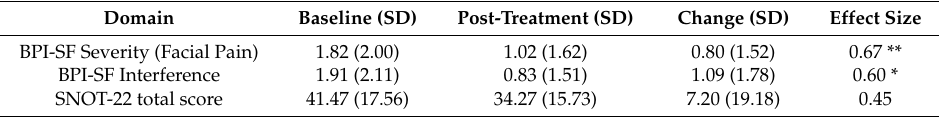
Table 3. Treatment results for patients with baseline pain ( n = 9). Mean scores, SD, mean change in scores, effect sizes (Cohen’s d ) and p -values are included.